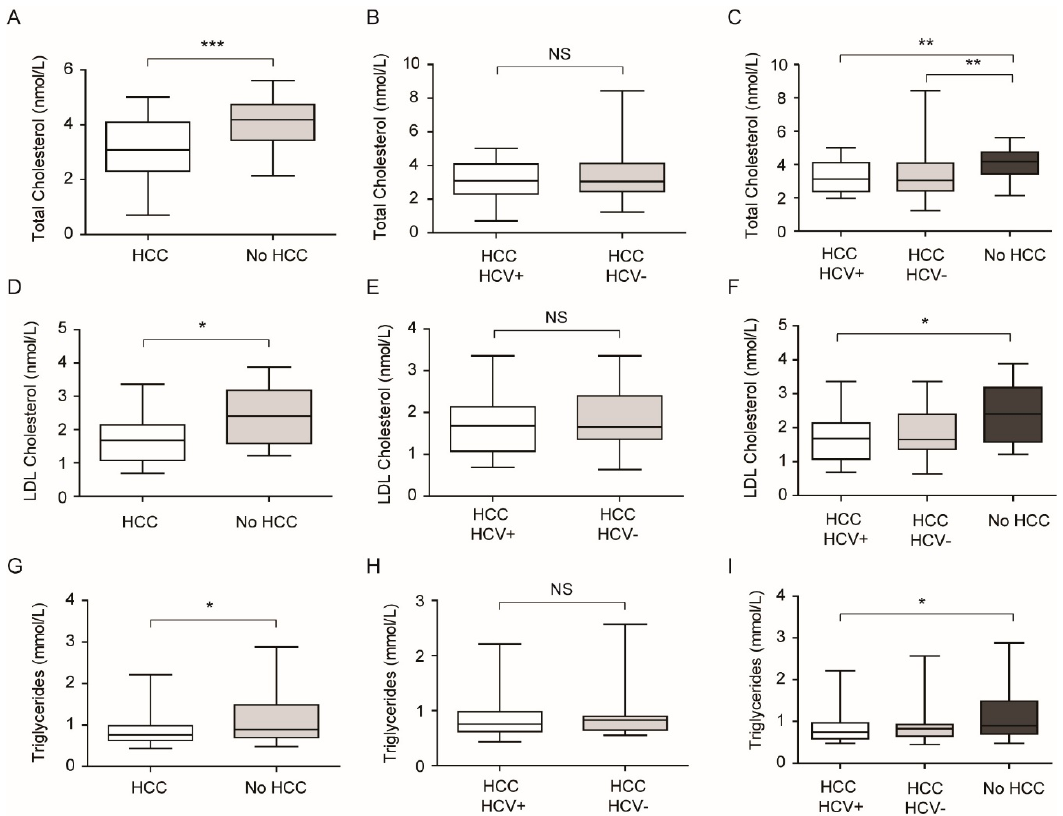
Figure 3. Cholesterol and TG levels in different patient subgroups. ( A,D,G ) The presence of HCC caused a decrease in TC ( A ), LDL-C ( D ) and TG ( G ) levels compared to no HCC patients; ( B,E,H ) no significant changes were observed between HCC HCV+ and HCC HCV- patients in TC ( B ), LDL-C ( E ) and TG ( H ) levels; ( C,F,I ) both HCC HCV+ and HCC HCV- subgroups showed lower TC ( C ), LDL-C ( F ) and TG ( I ) levels compared to no HCC population. * p < 0.05; ** p < 0.01; *** p < 0.001. NS: not significant.